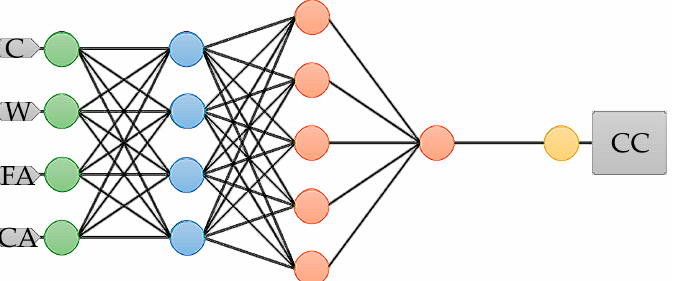
following parts, principal components (blue), perceptron neurons (red), and, because we use feature scaling, there are scaling and unscaling layer. The scaling and unscaling neurons are green and yellow, respectively. Abbreviations: [C]—cement; [W]—water; [FA]—fine aggregate; [CA]—coarse